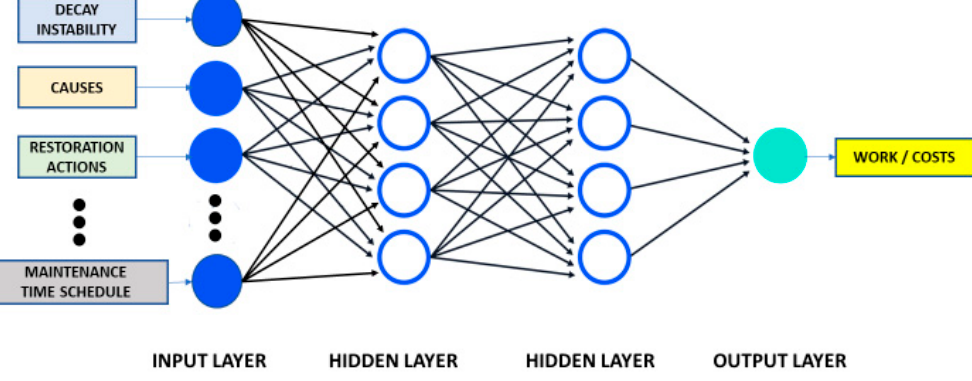
Figure 14. SyPEAH, diagram of the neural network.